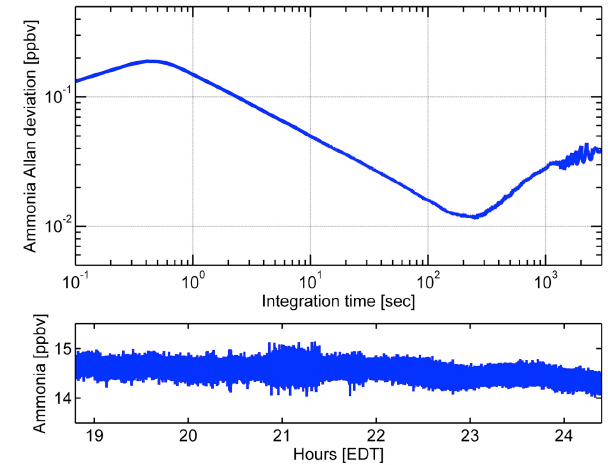
Fig. 5. Allan deviation plot of 14.6ppbv NH 3 and the associated Figure 5. Allan deviation plot of 14.6 ppbv NH 3 and the associated time series data recorded 2 time series data recorded at 10Hz over the course of at 10 Hz over the course of 5.5 hours. 3